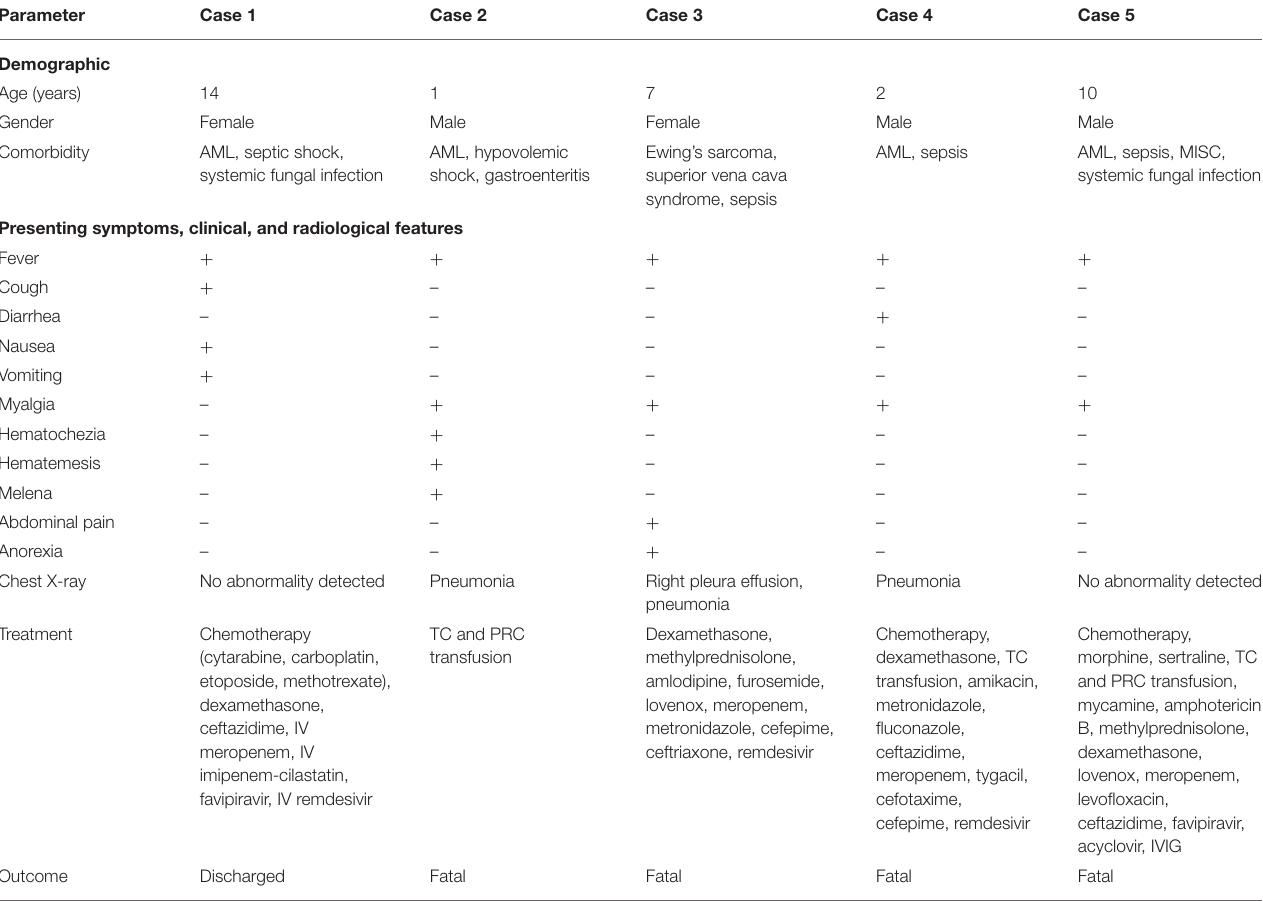
TABLE 1 | Symptoms, clinical, radiological features, treatments, and outcomes of the pediatric patients.